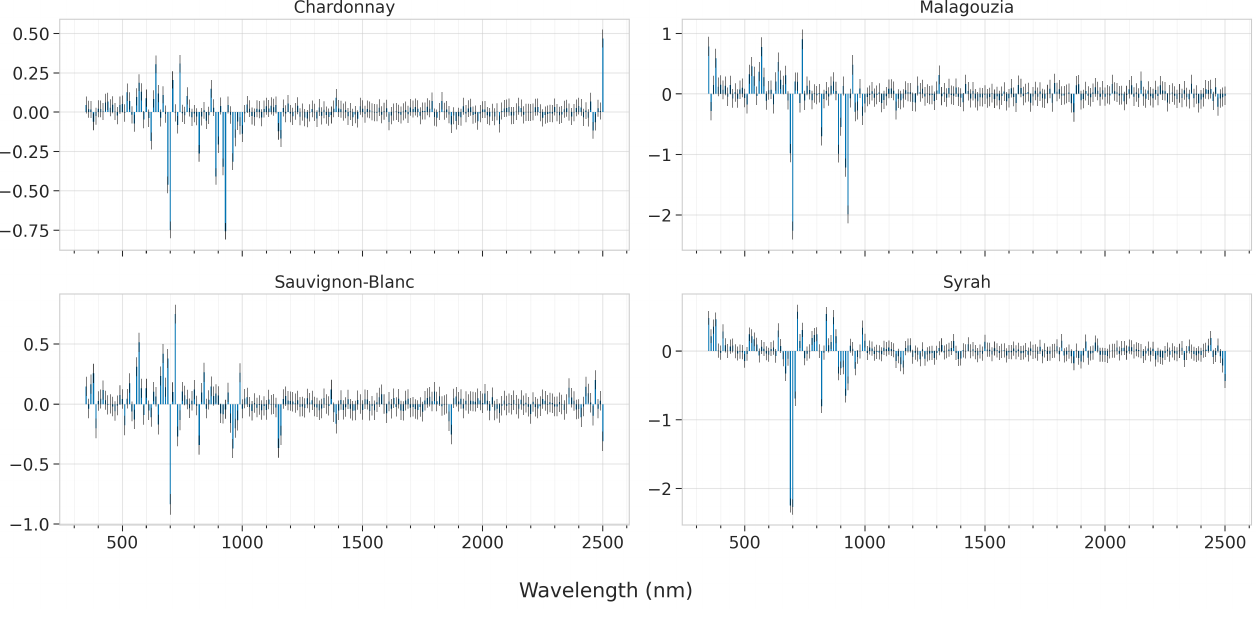
Figure 15. Mean feature importance according to SAGE values for the best CNN model across the five folds and for each of the four grape varieties; the higher the bar, the more informative the feature about the °Brix